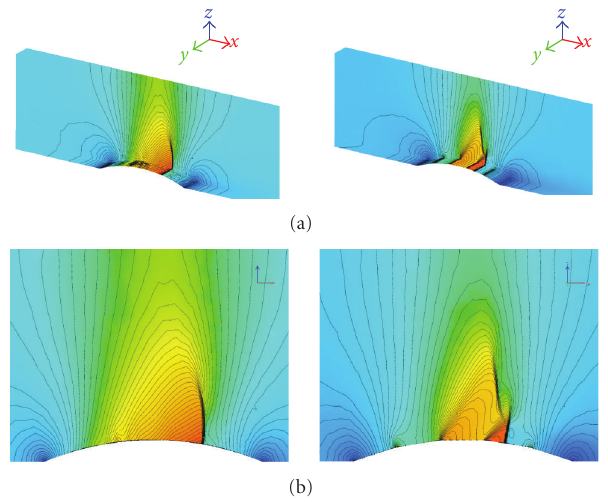
Figure 21: Final solutions with (left) and without (right) projec- tion. (a) Mach number solution field and C p isolines and (b) details from the side.